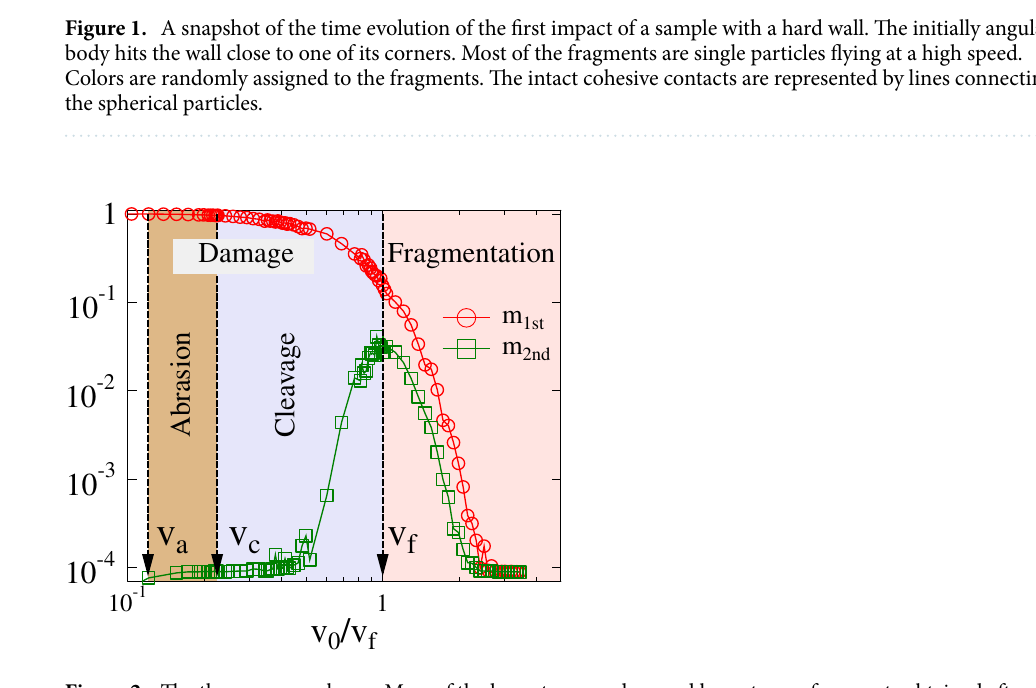
Simulations revealed that for sufficiently low impact velocities v 0 < v a the sample solely underwent deforma- tion around the impact site and rebounded elastically without suffering any damage. Cracks first occurred when v for high impact velocities cracks can span the entire sample giving rise to rapid breakup. To give a quantitative characterization of the final outcome and the degree of destruction caused by impacts, we determined the average masses M 1 st and M 2 nd of the largest and second largest fragments, respectively. After normalizing these values by the total mass M 0 we plotted m 1 st = � M 1 st / M 0 � , m 2 nd = � M 2 nd / M 0 � as function of the impact velocity v 0 . It can be observed in Fig. 2 that at low impact velocities we have m 2 nd ≪ m 1 st , i.e. the second largest fragment is orders of magnitude smaller than the largest one, showing that only small pieces are removed from the body around the impact site. This is characteristic for the damage energy phase . Fragmentation is achieved when the second largest piece becomes comparable to the largest one, which first occurs at the maximum of m 2 nd defining the critical velocity v f of fragmentation. Beyond the critical fragmentation velocity v f both m 1 st and m 2 nd decrease monotonically. Figure 2 shows that, depending on the velocity, single impacts give rise either to damage or frag- mentation of the sample with a sharp transition at the critical velocity v f . The damage–fragmentation transition